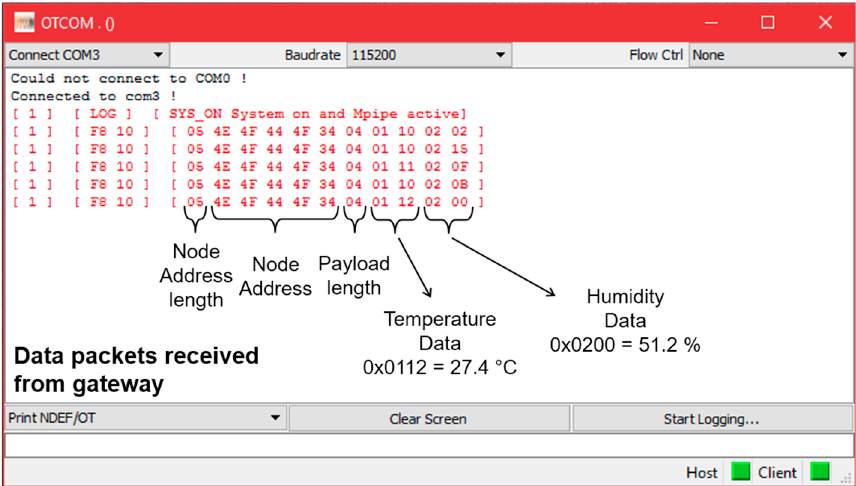
Figure 18. Voltage drop and control signals of micro-controller in off-mode ( a ) and standby-mode ( b ). Transmitted data are then received by a dedicated gateway, which displays data directly onto a PC terminal. Figure 19 shows the received data bytes with different sensor values.